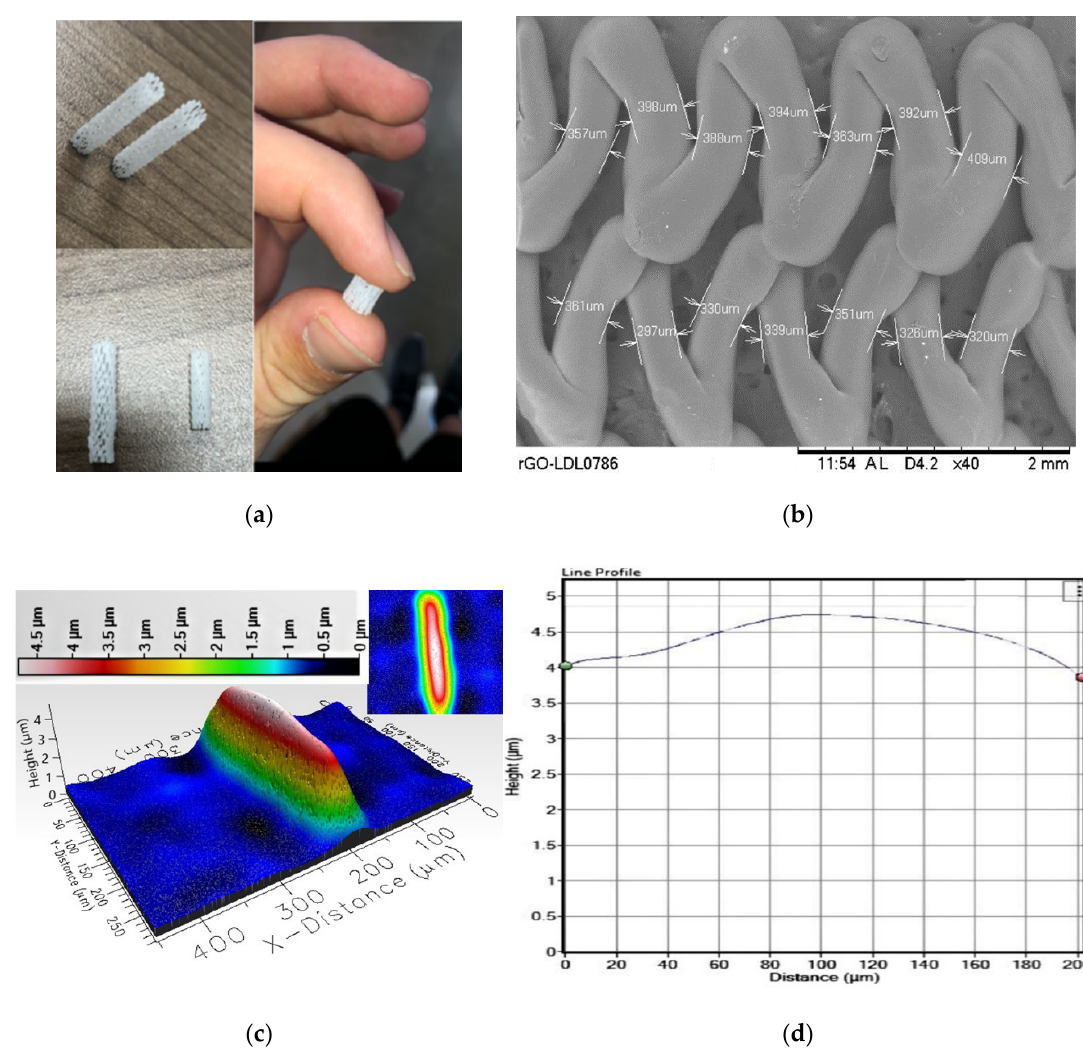
Figure 2. ( a ) Developed Polycaprolactone (PCL) flow diverting stent (FDS) with different lengths and diameters; ( b ) SEM images of the FDS surfaces and the width measurements; ( c ) Surface topography of the PCL FDS surfaces in 3D profilometer and ( d ) sub-micrometer scale wavy nature of the FDS surface topography.